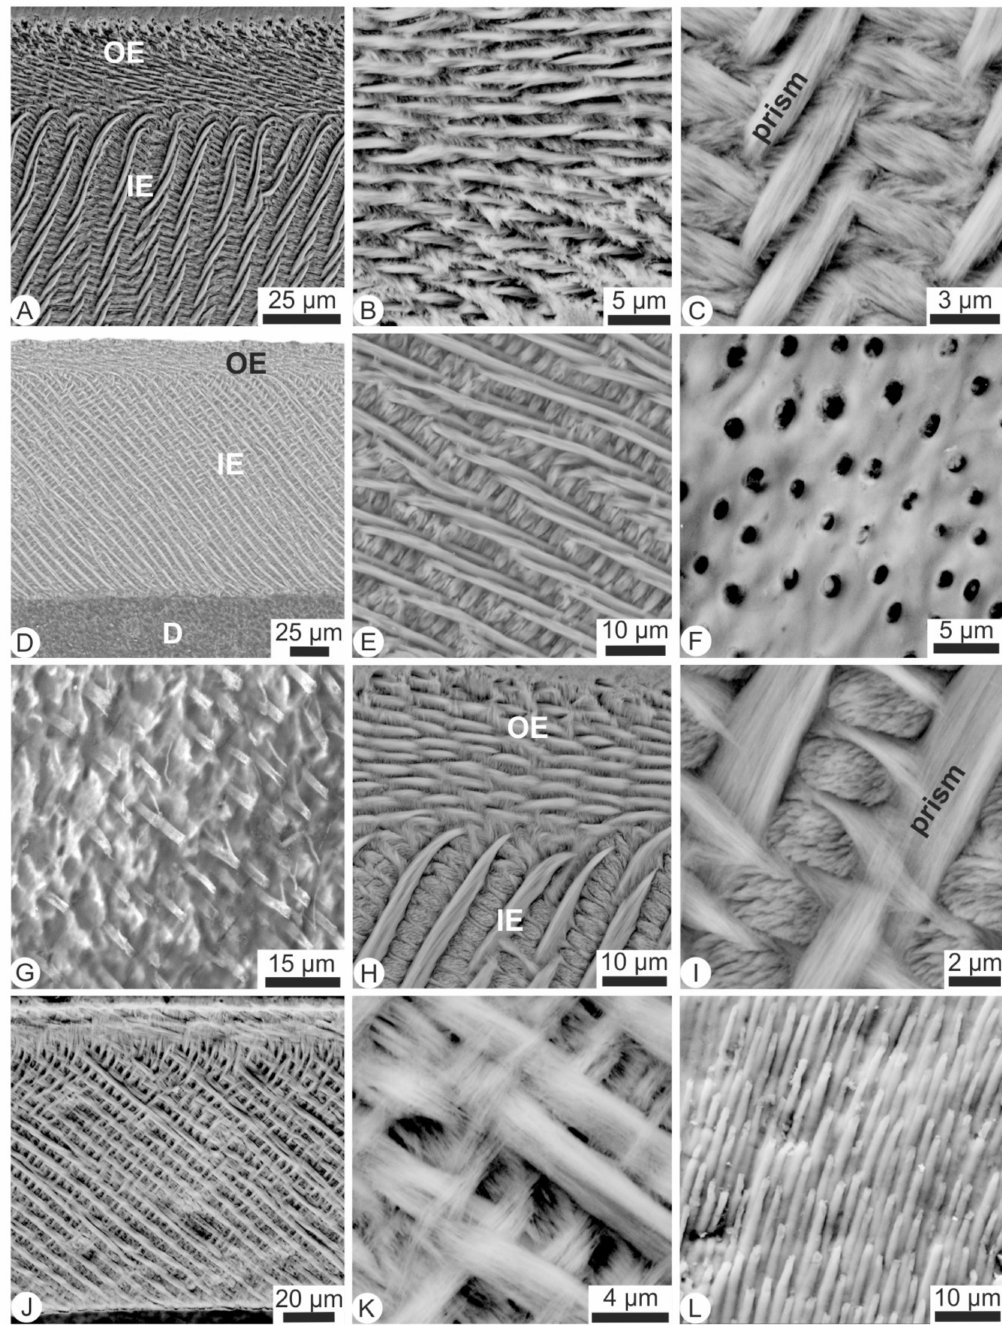
Figure 1. Polished and etched sections of incisors ( A – I ) and molars ( J – L ) of recent fresh (not digested) rodent teeth. ( A )— Rattus , showing an outer prismatic sublayer (OE) (also called portio externa ) and a thick inner prismatic sublayer (IE) (or portio interna ), formic acid 5% for 10 s.; ( B )—Detail of the prismatic outer sublayer; ( C )—Detail of the prisms of the inner sublayer showing elongated crystallites; ( D )— Mus , showing two prismatic sublayers (OE); ( E )—Detail of the enamel inner sublayer; ( F )—Empty tubules of dentine of the same tooth; ( G )— Mus , showing tubules still filled with cellular processes; ( H )—Parasagittal section of Meriones , showing an enamel arrangement similar to those of Rattus and Mus, HCl 1% for 15 s.; ( I )—Detail of the structure of the inner sublayer of enamel; ( J )—Uniserial pattern of the inner enamel sublayer and the thin outer sublayer in a molar of Mus, HCl 1% for 15 s.; ( K )—Detail of inner structure of the prisms; ( L )—Parallel tubules of the dentine in a Mus